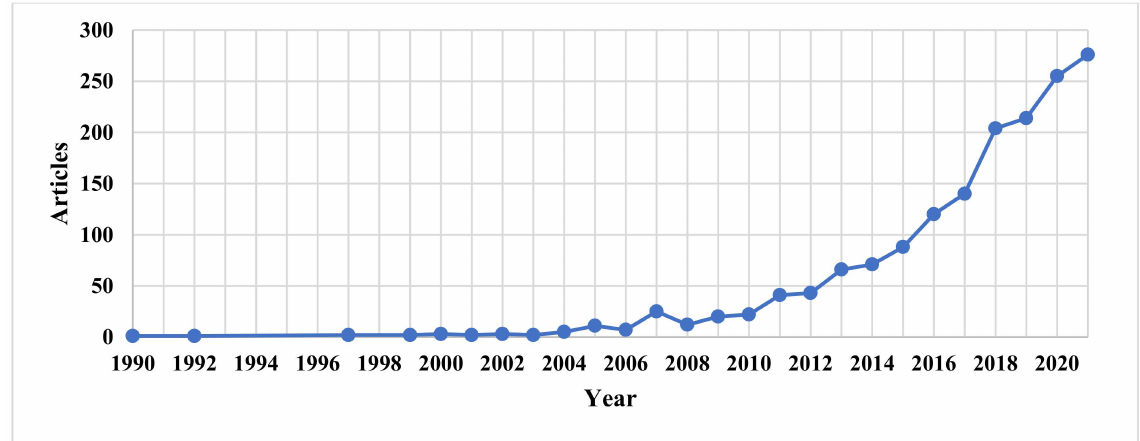
Figure 1. Annual scientific production. Source: own study using data from Bibliometrix.